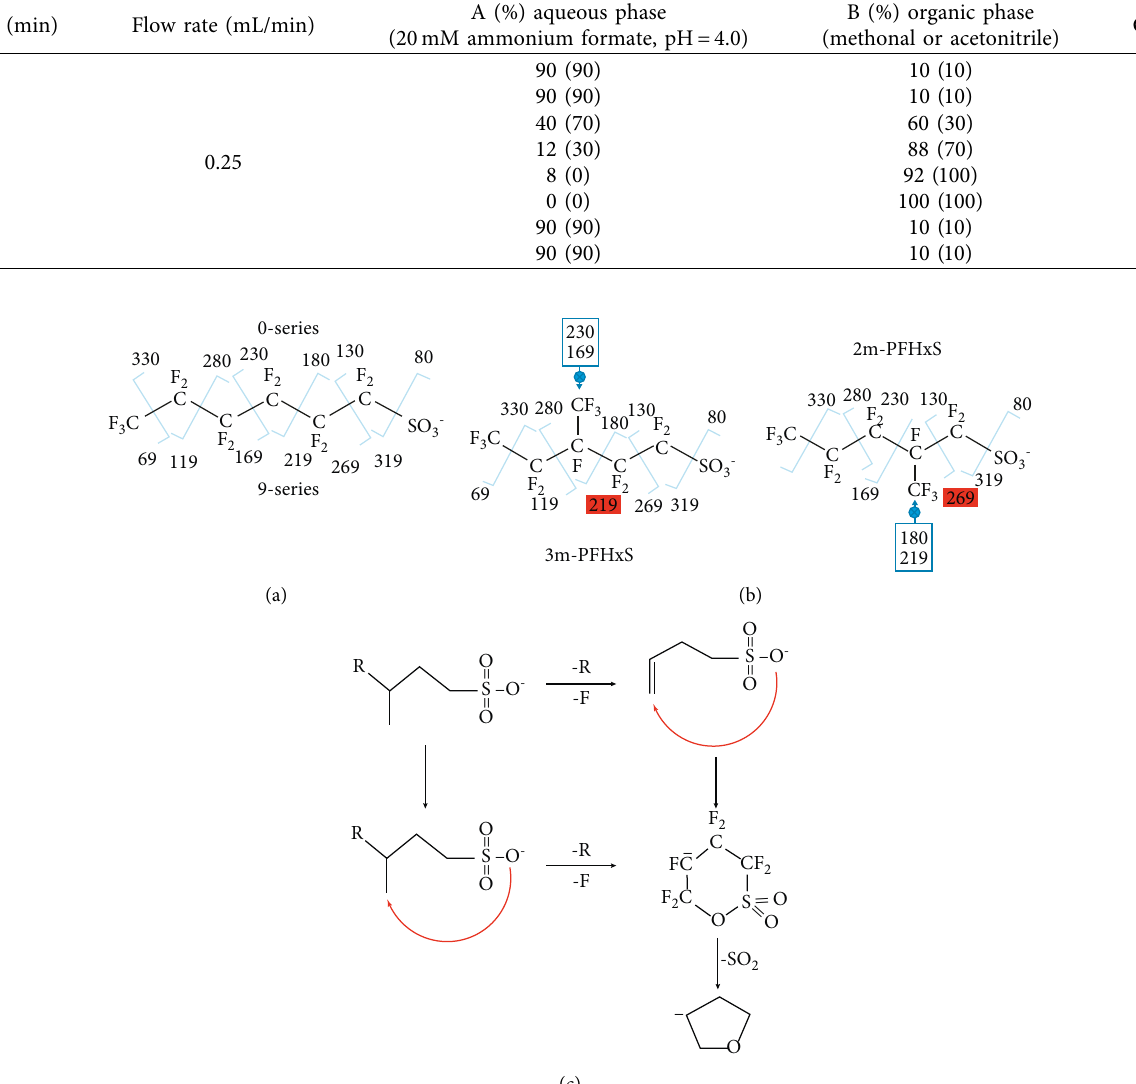
Table 1: Gradient eluting procedures for isolation of PFHxS